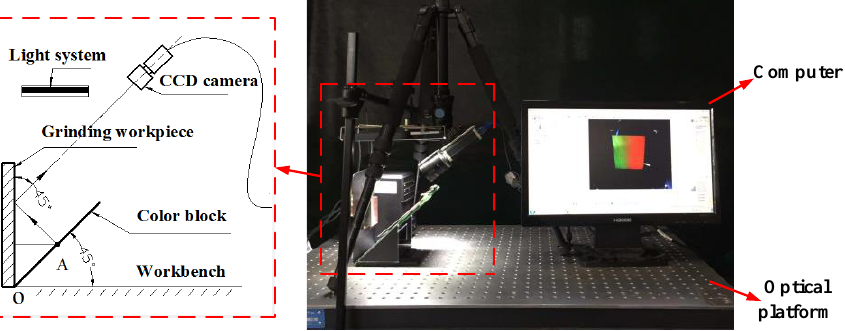
Figure 5. Experimental model and device.